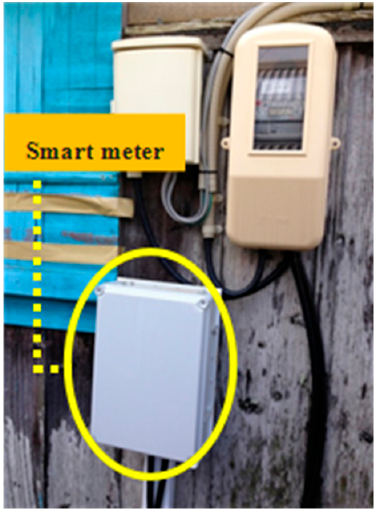
Figure 2. A smart meter established at one household. Energies 2016 , 9 , 1093